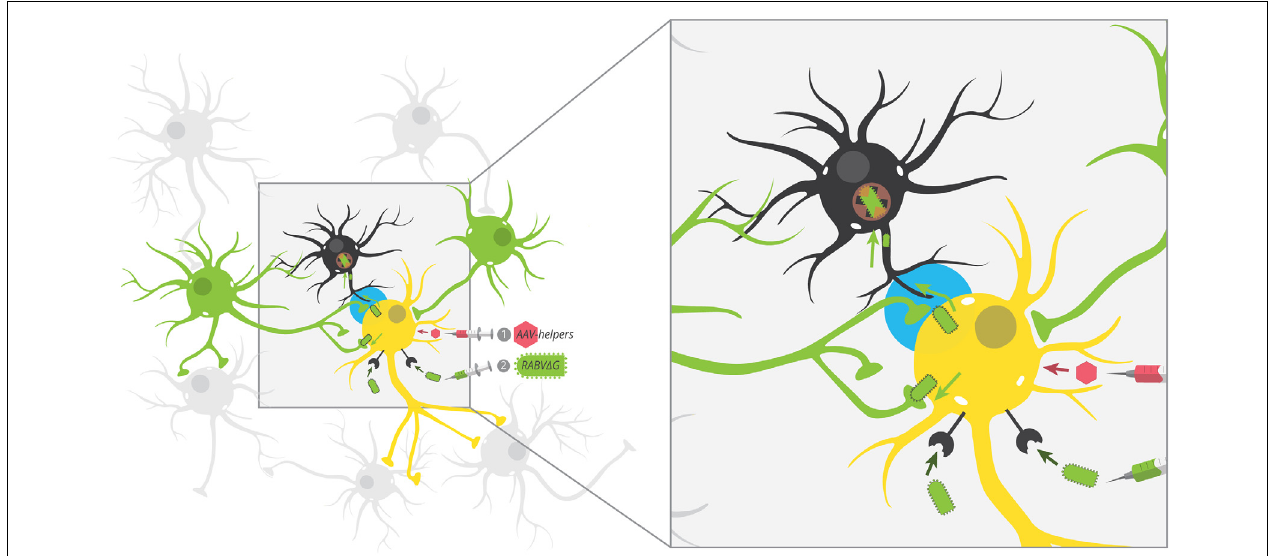
FIGURE 2 | Potential unobserved glial infection using one-step RABV. AAV helpers expressing red fluorescent protein mark starter cells, which are then targeted by EnvA-pseudotyped RABV by cellular expression of TVA. Because RABV encodes GFP, this makes starter cells red + green = yellow. By trans-complementation, RABV can spread to direct input cells (green). According to our postulated model, RABV may also spread to nearby glial cells (black), but these infections are aborted and thus, glial cells don’t express GFP. This leaves the GFP label specifically in neurons that preferentially connect to starter neurons. The tripartite synapse is highlighted in